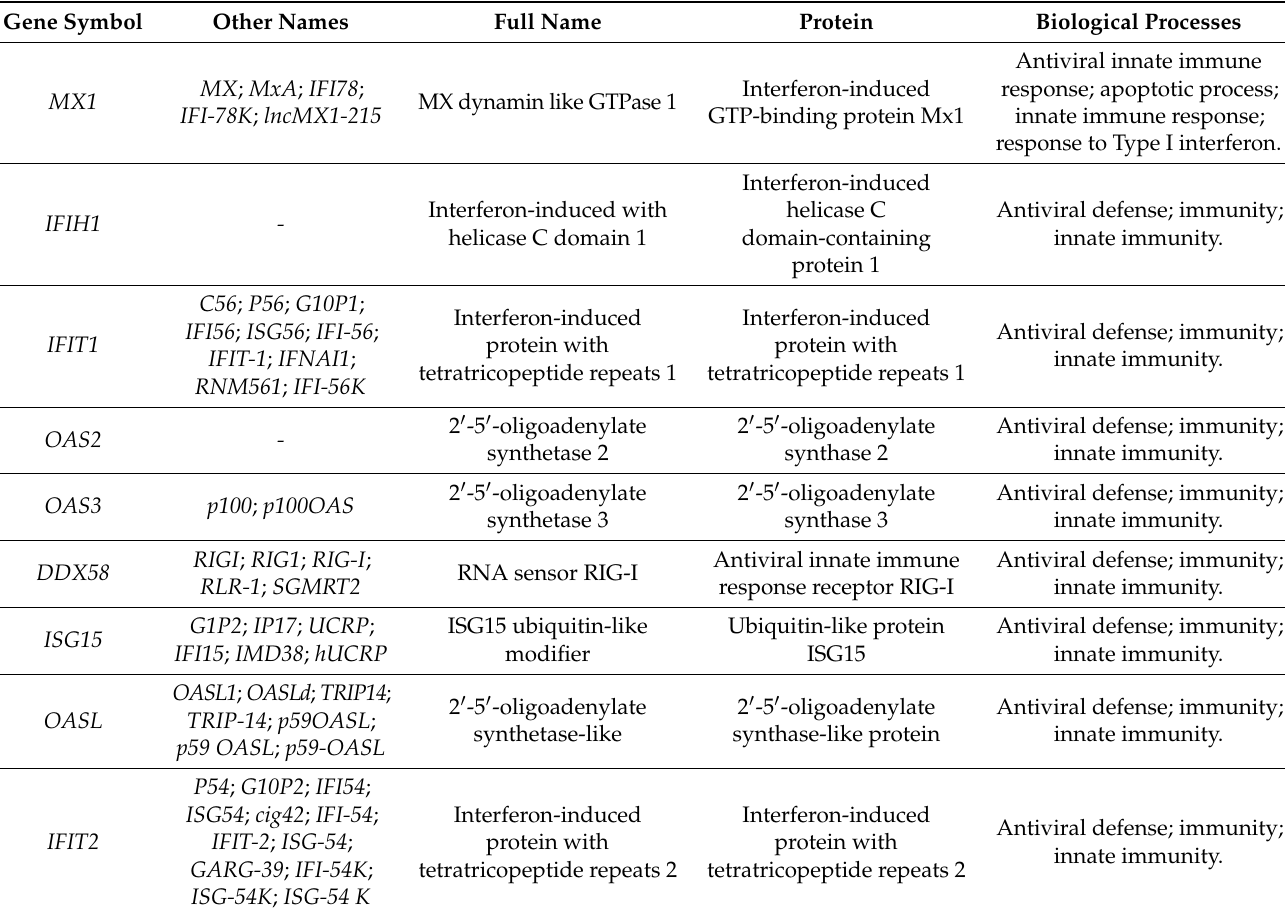
Table 5. Functional roles and general information of the up-regulated hub genes.